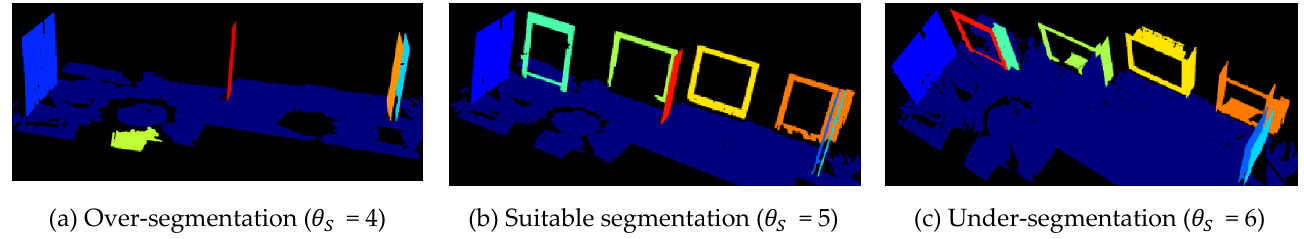
Figure 11. Segmentation results of different (cid:2016) (cid:3020) values